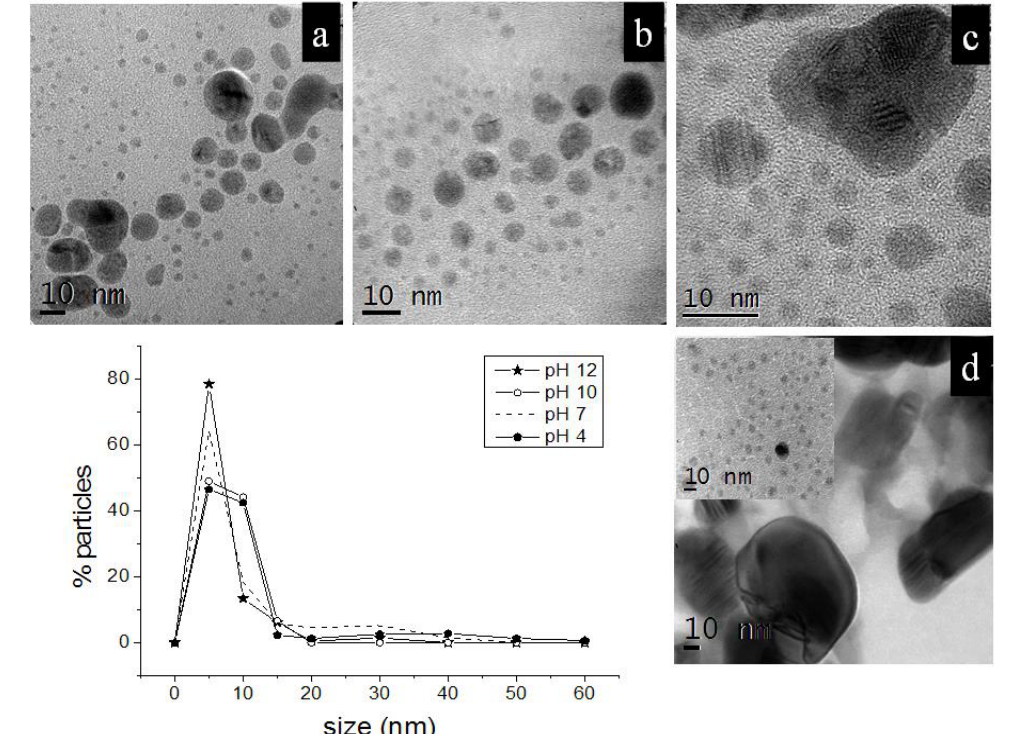
Fig. 3. Size distribution analysis of the produced nanoparticles for the different pH conditions for leaves. TEM images for